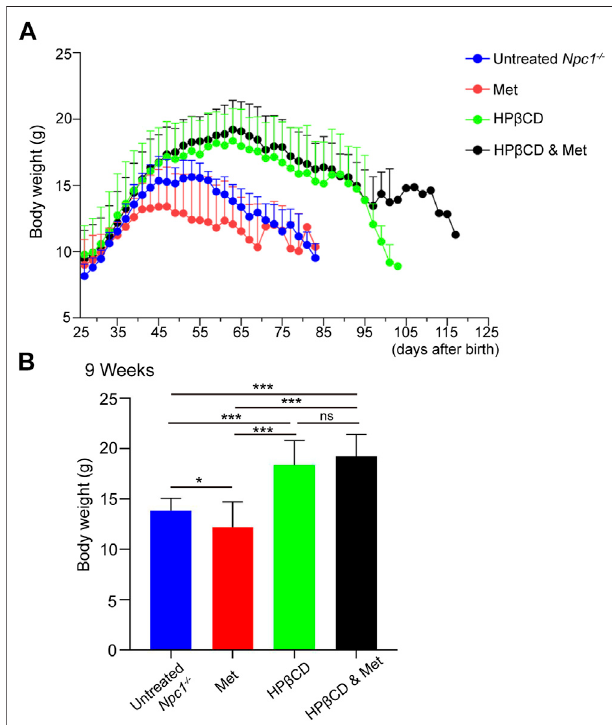
FIGURE 2 | Effect of test drugs on body weight of in Npc1 − / − mice. The mean weight for each treatment group is plotted against age (A) . The maintenance of weight in each treatment group is shown as the mean weight for each group at 9 weeks of age in (B) . Statistical analysis is based on one-way ANOVA followed by Tukey test, ns represents not signi fi cant, * p < 0.05, *** p < 0.001. All data are provided as means ± SEM.